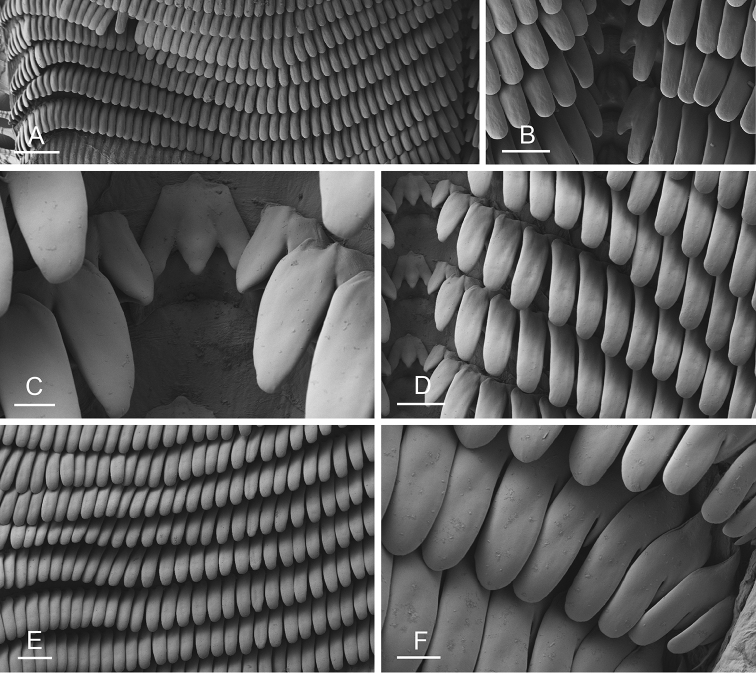
Radula, Peronia
okinawensis, Japan, Okinawa A, B holotype [696-4 H] (UF 352288) C–F [696-2] (UF 352288) A left half rows of teeth B rachidian and innermost lateral teeth C rachidian and innermost lateral teeth D rachidian and lateral teeth E lateral teeth F outermost lateral teeth. Scale bars: 200 μm (A), 80 μm (B), 20 μm (C, F), 60 μm (D), 100 μm (E).